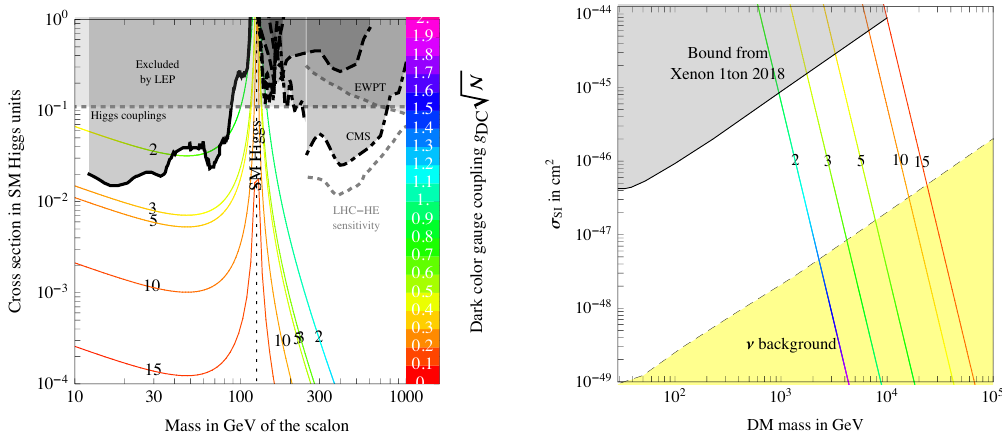
Figure 2 . Predicted cross sections for the extra scalar boson (left) and for DM direct detection (right) as function of the only free parameter of the model g DC , varied as shown in the color legend. We here assume that DM has its cosmological abundance, and that it is negligibly a(cid:11)ected by annihilations among dark baryons. The values of N are indicated on the